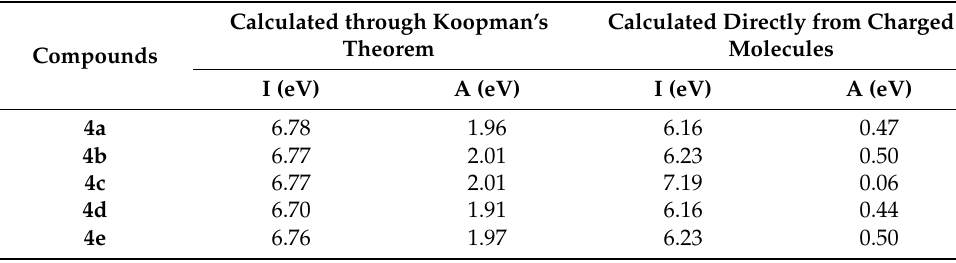
Figure 6. FMO surfaces of compounds 4a – 4n computed at the PBE0-D3BJ/def2-TZVP/SMD 1,4-dioxane level of theory. Table 3. Ionization potential (I) and electron affinity (A) of compounds 4a – 4n calculated through Koopman’s theorem and directly, i.e., through optimization of charged